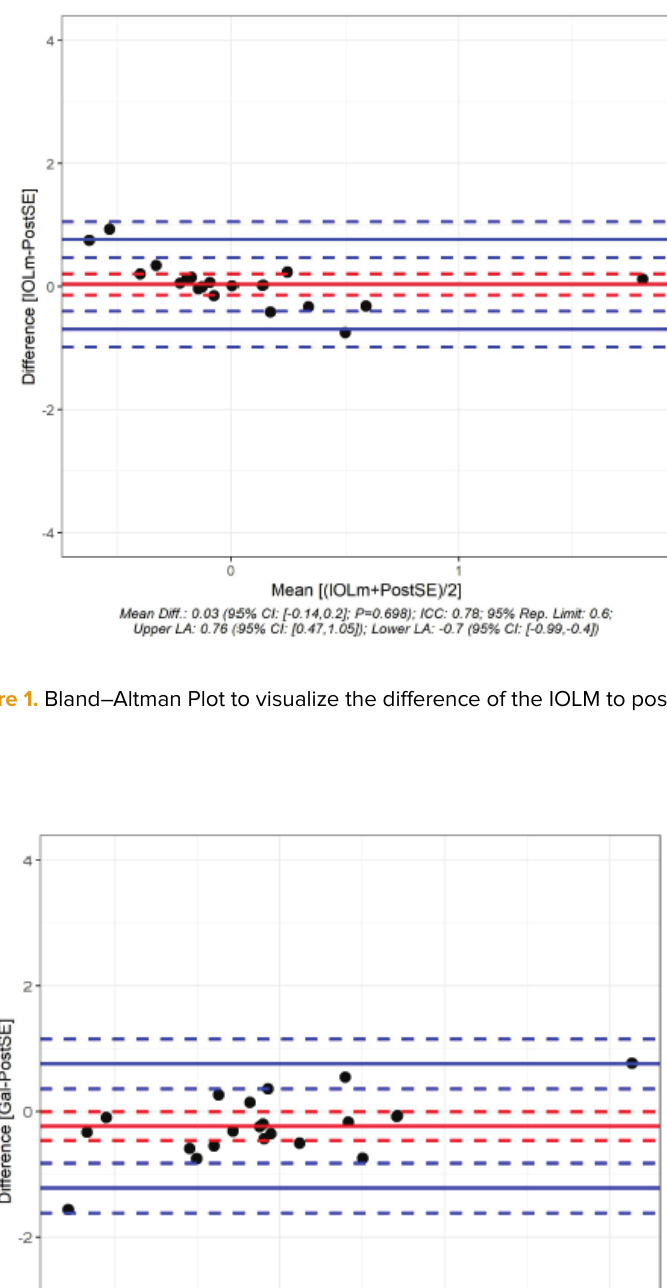
JOURNAL OF OPHTHALMIC AND VISION RESEARCH Volume 17, Issue 4, October-December